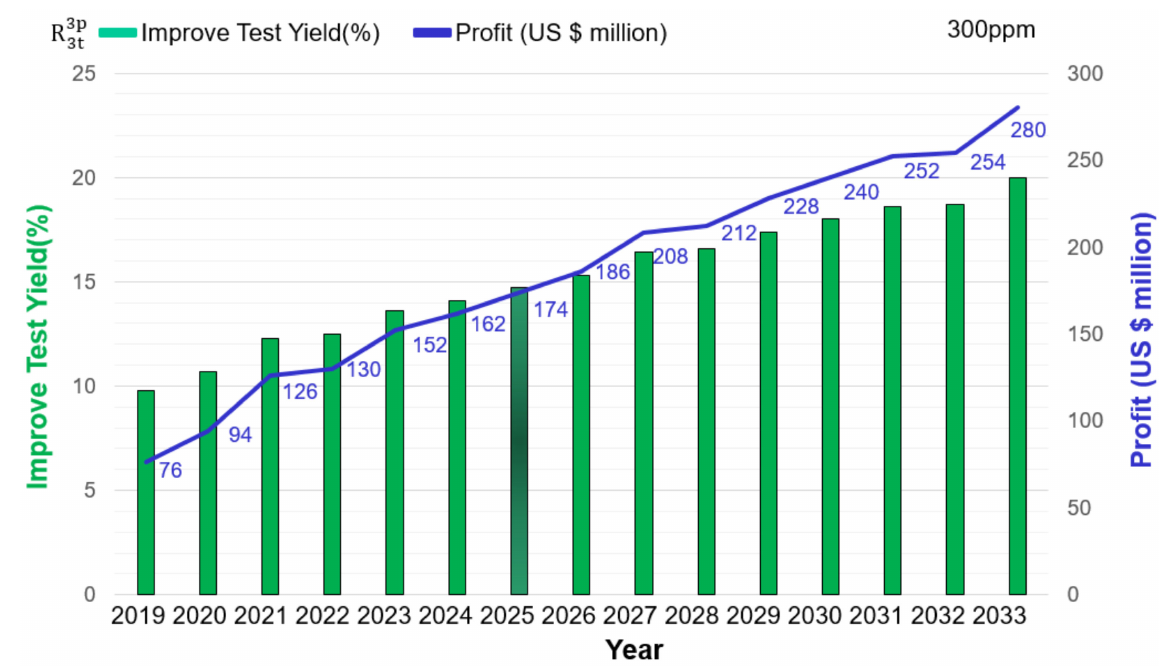
Figure 12. The test method affects the company’s total profit (300